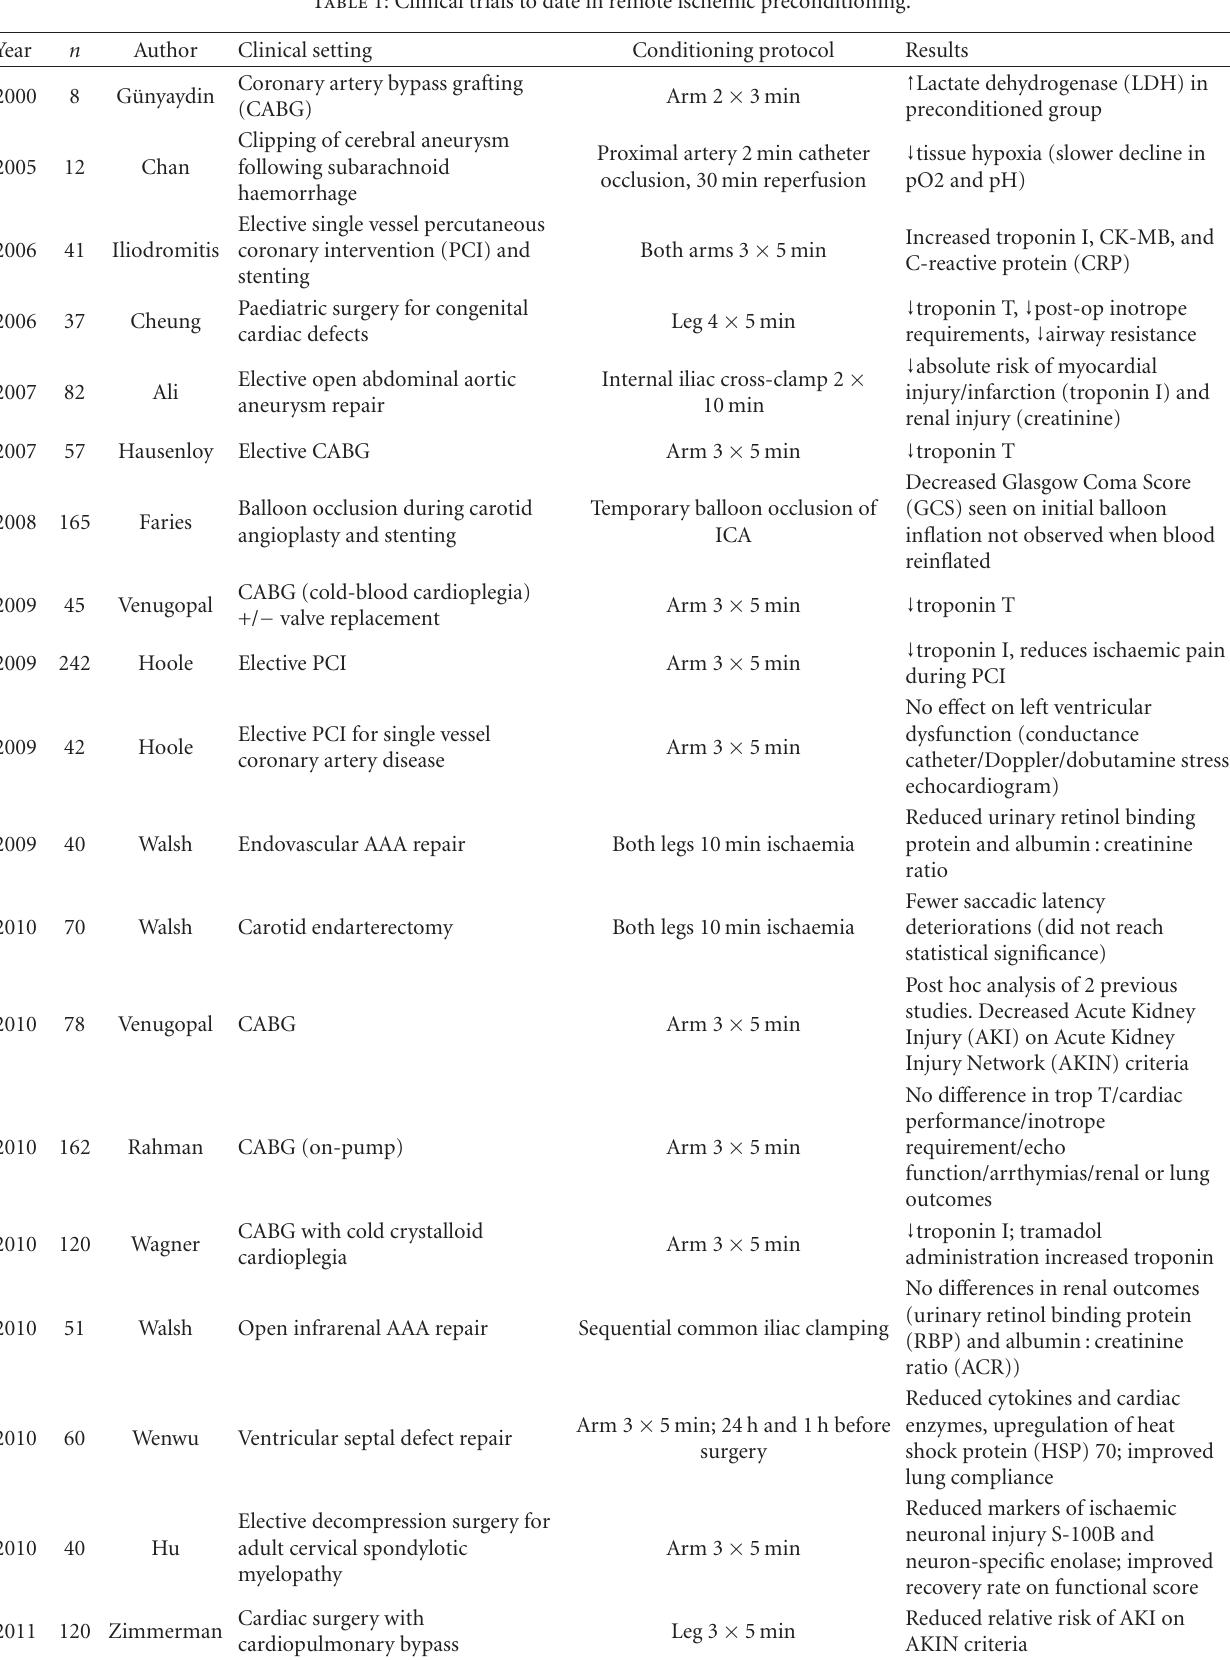
Table 1: Clinical trials to date in remote ischemic